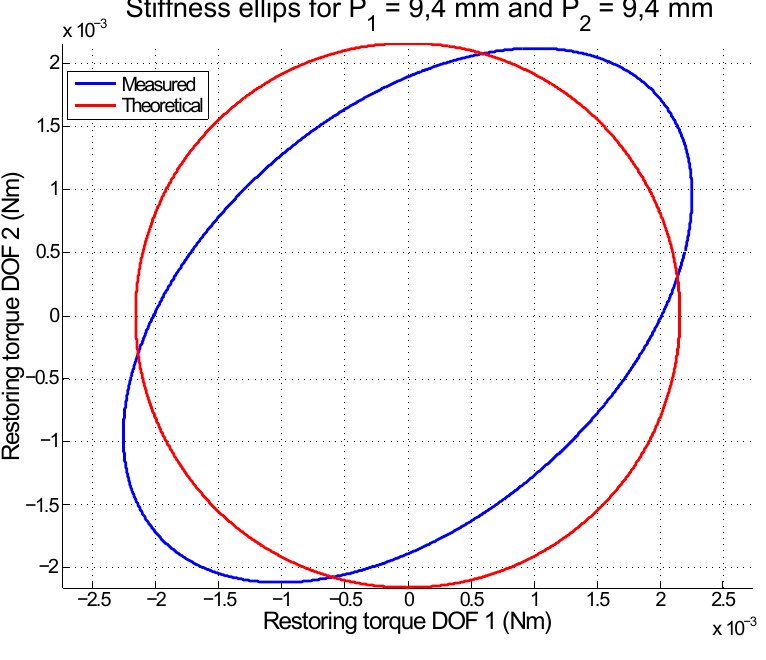
Figure 14. The measured and theoretical stiffness ellipses of the two-degree of